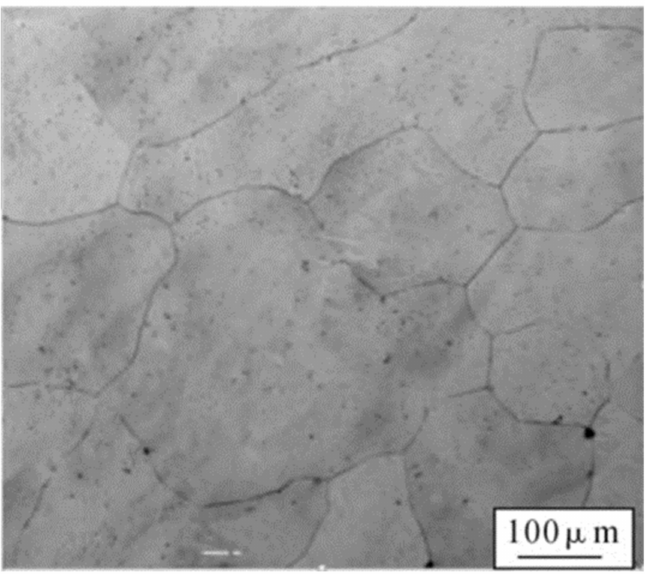
Figure 3. Microstructure of Co 32 Cr 28 Ni 32 . 94 Al 4 . 06 Ti 3 .